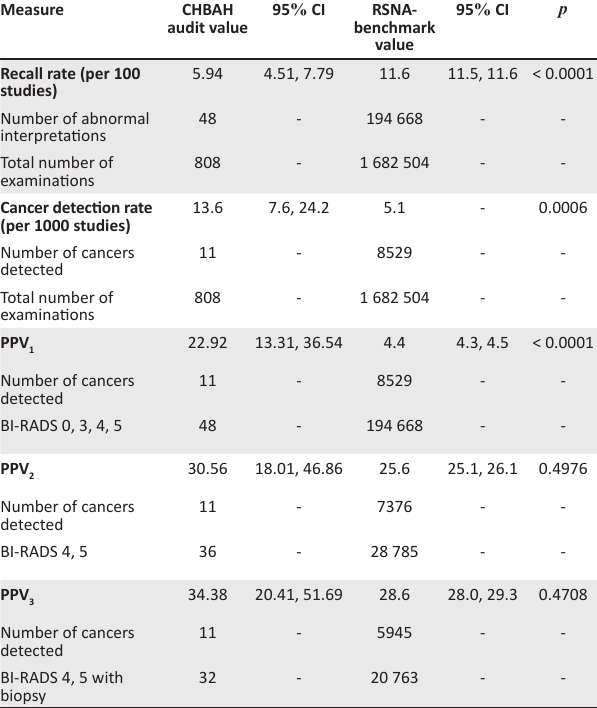
TABLE 4: Derived performance measures for screening mammography ( n = 808). Measure